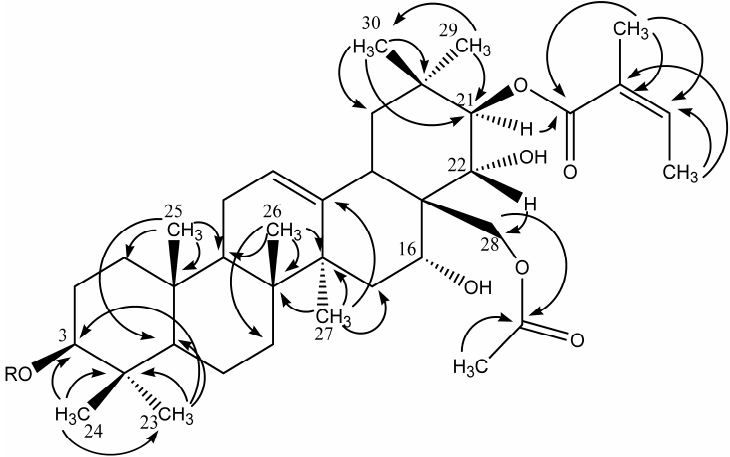
Figure 2. Key HMBC correlations of the aglycone moiety of compound 1 .